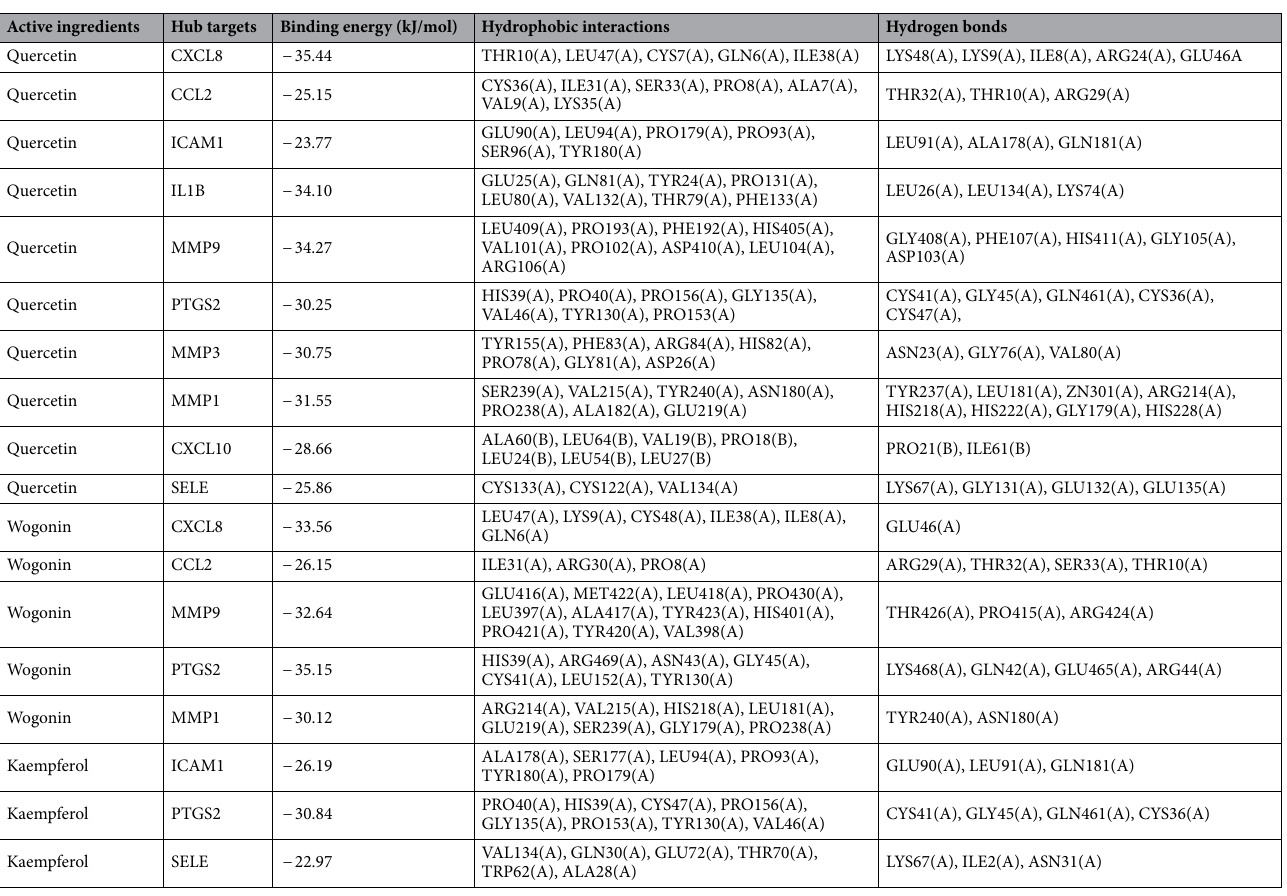
Table 3. Screening docking results between ligands and